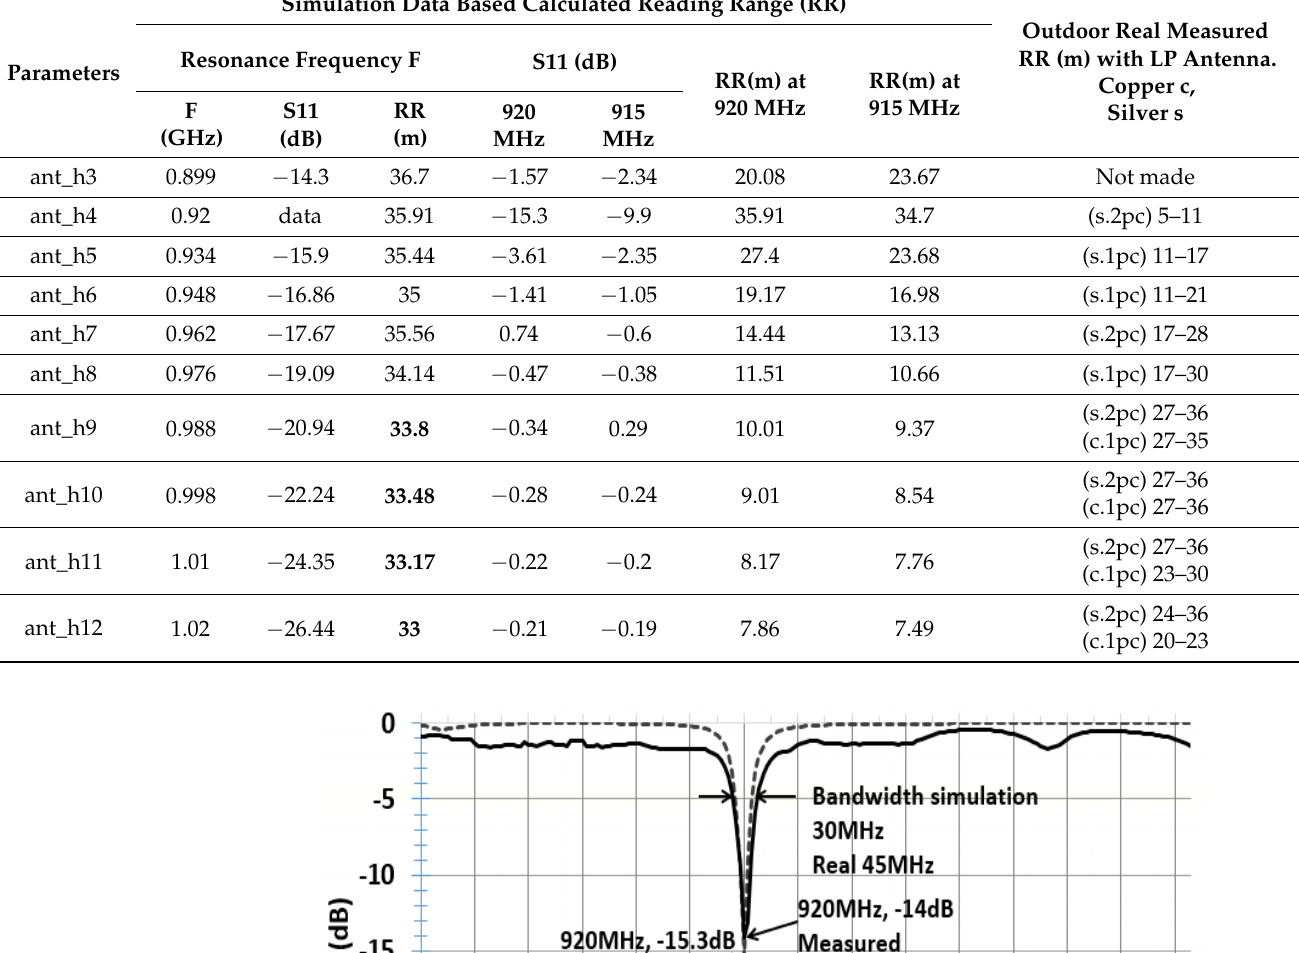
Table 2. Simulation and measured parameter reading range with different sizes of ant_h.